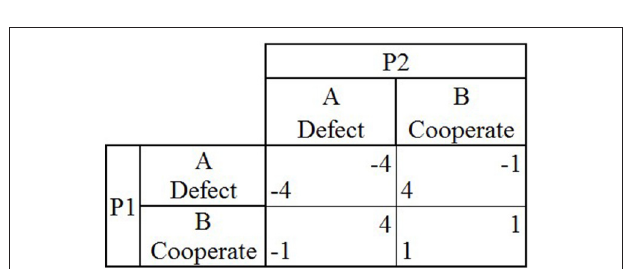
FIGURE 2 | The payoff matrix for the game Chicken shows the two players (P1 and P2), the two possible choices they can make during each round (A or B) and the four possible outcomes that can occur during a single round (P1’s payoff is located in lower left hand corner and P2’s payoff is located in upper right hand corner) depending on the choices made by both players in that round.